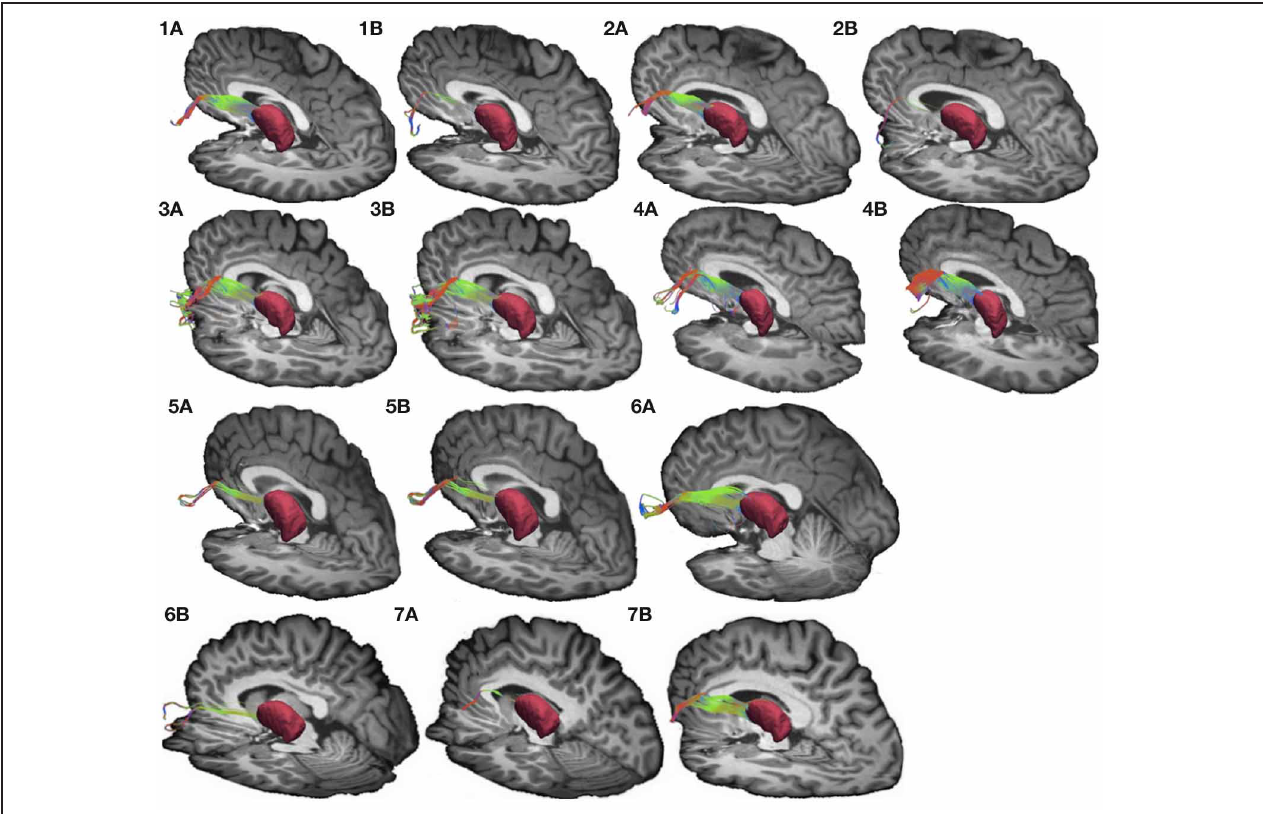
FIGURE 4 | Connections between pars triangularis (A) and pars opercularis (B) and the thalamus (pink) in our ten participants. Color gradient represents the same directionality as in Figure 1 .